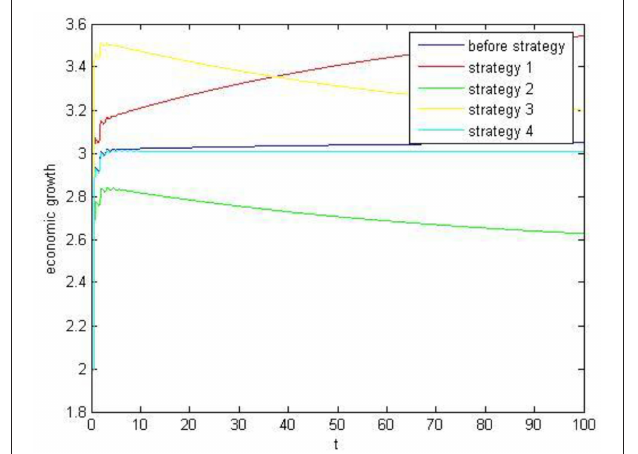
FIGURE 7 | Economic growth strategy chart.